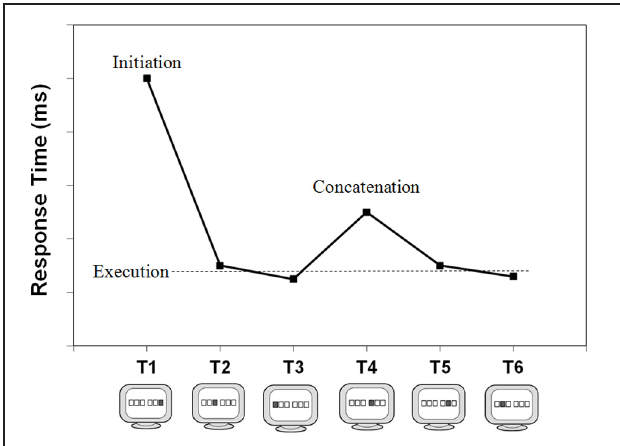
FIGURE 2 | Executing a 6-key sequence and its typical reaction time pattern. It involves the processing phases initiation, concatenation, and (mere) execution. Please note that with smaller sequence lengths ( < 5 key-presses) the relatively slow T half way through (concatenation) is not typically